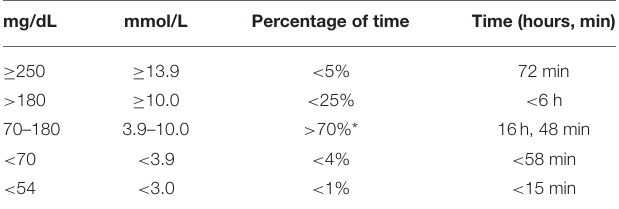
TABLE 8 | International consensus for clinical CGM